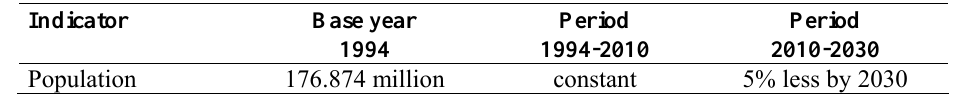
Table 1. Socio-economic and other indicators assumed for the study